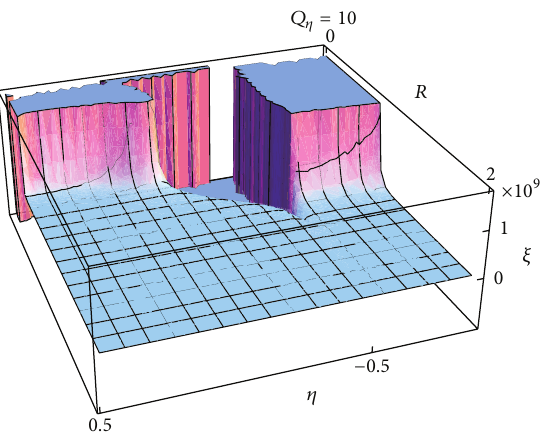
Figure 12: 5D Kretschmann invariant (5) 𝜉 for 𝑄 𝜂 = 1 , for Λ = −1 .